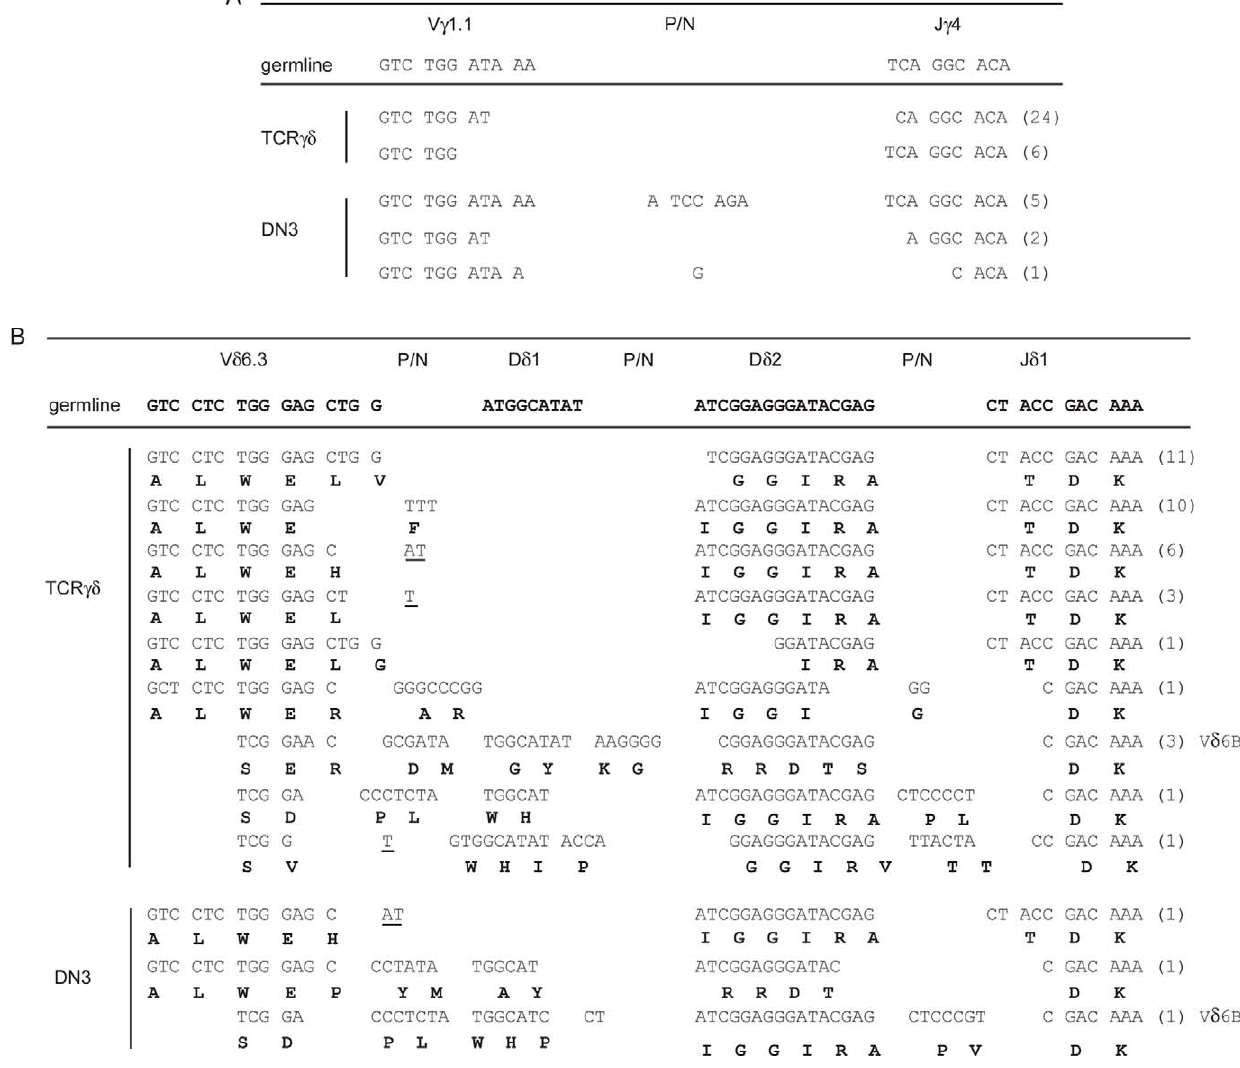
Figure 5. Sequence analysis of V c 1.1-J c 4 and V d 6-J d 1 junctions. Sequence of V c 1.1 and J c 4 (A) or V d 6 and J d 1 (B) junctions from TCR cd + T cells (upper, indicated on the right) or DN3 thymocytes (lower, indicated on the right). Data are cumulative from 2 independent experiments in which DNA was isolated 50,000 TCR cd + cells and 30,000 Lin 2 c- kit 2 CD25 + (DN3) cells. In each experiment 3 independent PCR amplifications were performed on each population and cloned into pBSK for sequencing. A minimum of 30 sequences were analyzed for each population. Results from the